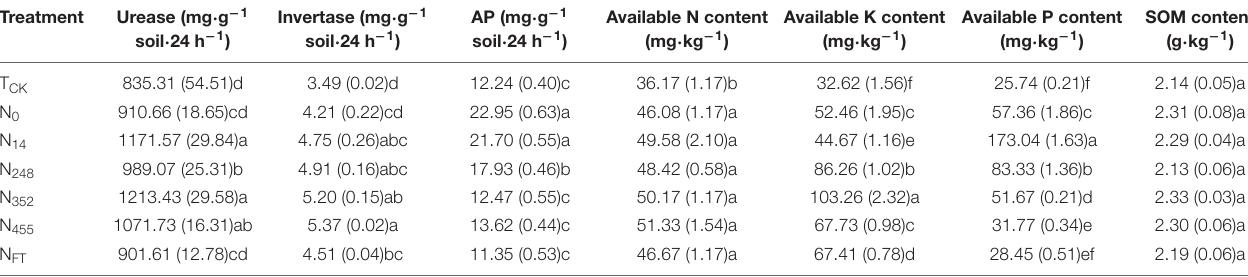
TABLE 1 | Soil properties of the banana field under different nitrogen fertilization rates. Treatment